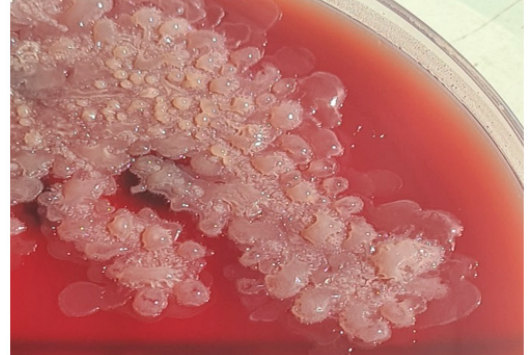
Figure 3. Radiobacter colonies on Columbia blood agar.